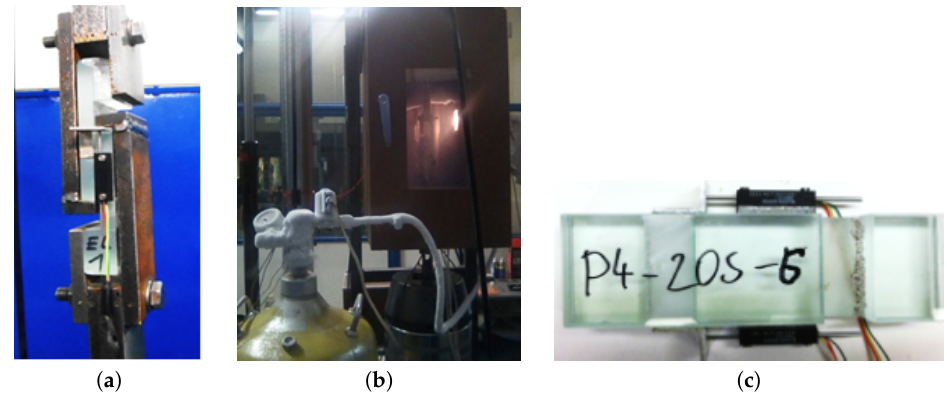
Figure 4. ( a ) MTS machine metal jaws of a single-lap shear test, ( b ) climatic chamber for dynamic